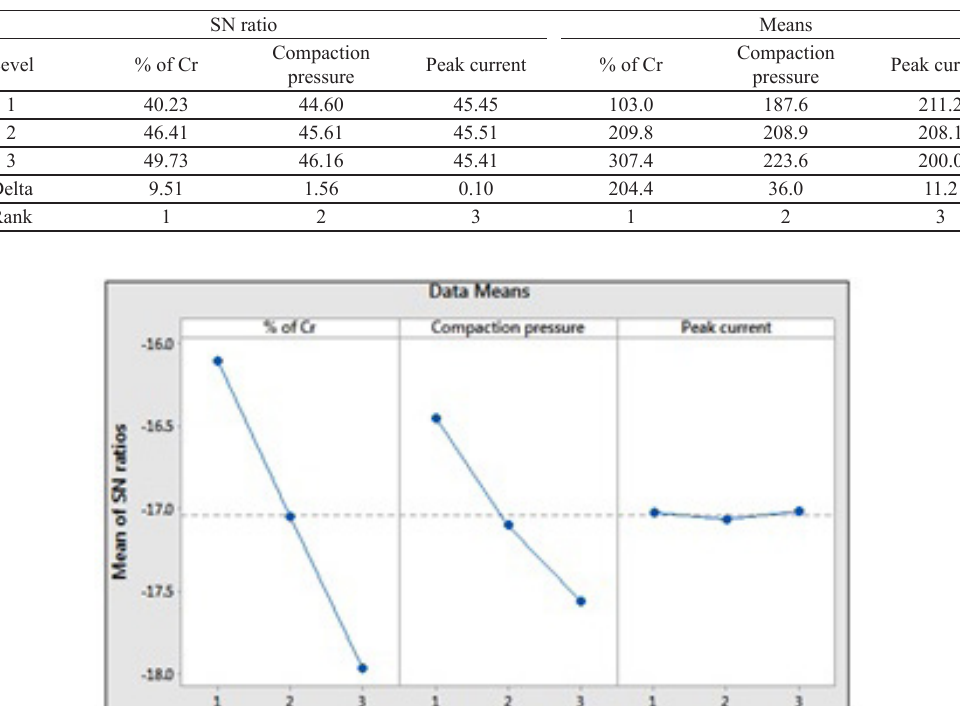
Table 7. Calculated SN ratio and means for MTR.